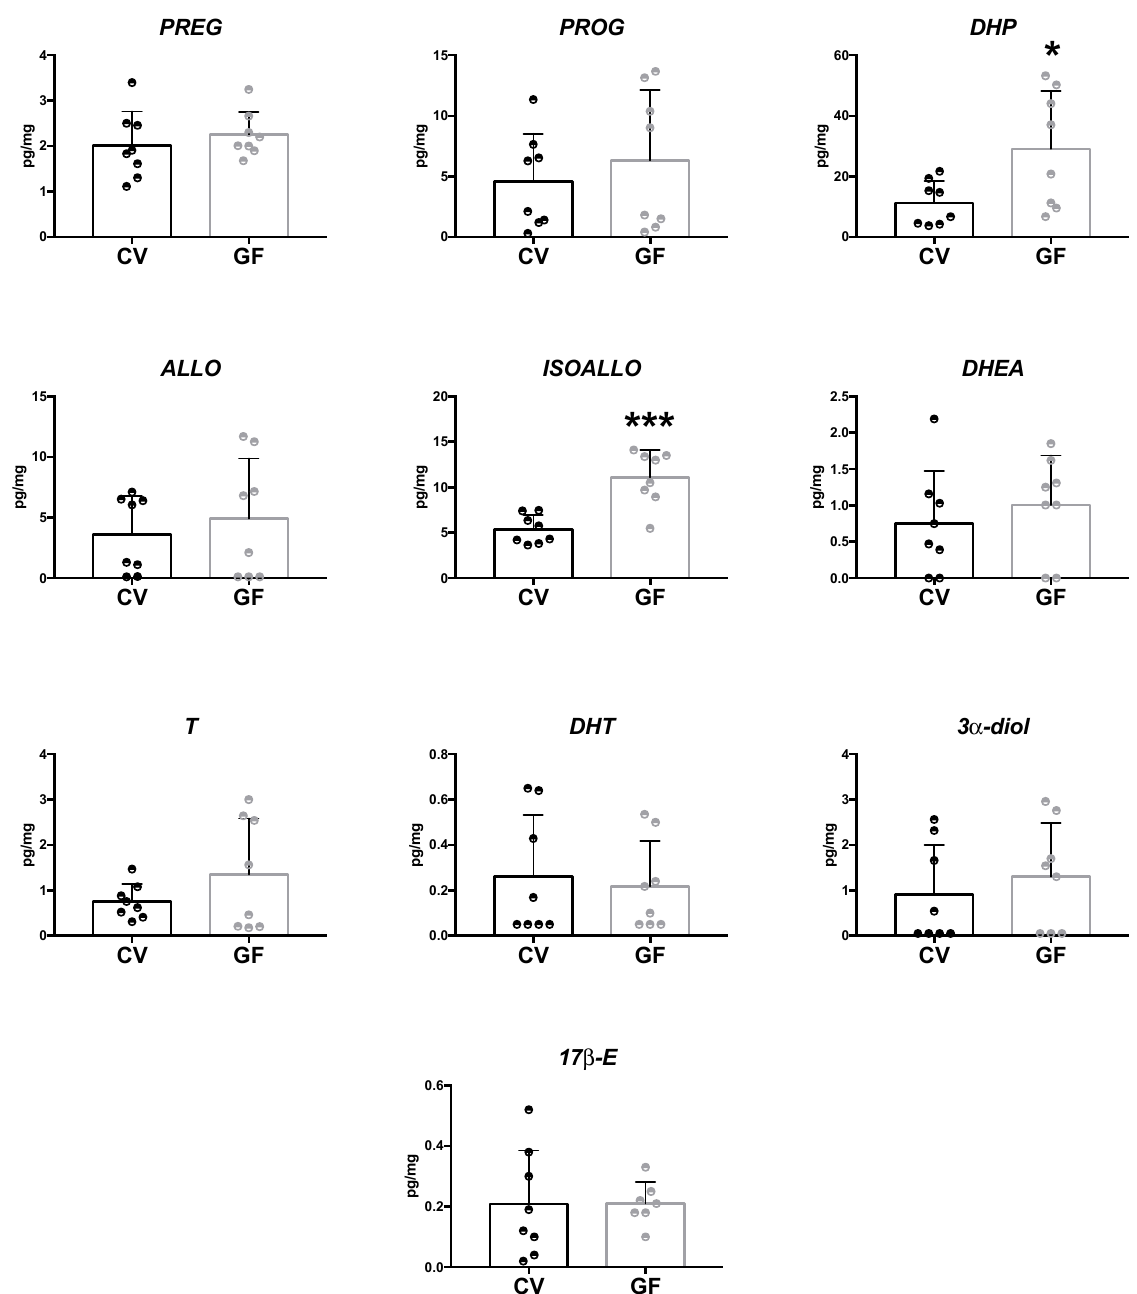
Figure 3. Levels of neuroactive steroids in the cerebellum of germ-free (GF) and conventional (CV) male mice. Data are expressed as pg/mg ± SD, n = 8 for each group. Unpaired student’s t -test analysis: * p < 0.05 *** p < 0.001 vs. CV mice.